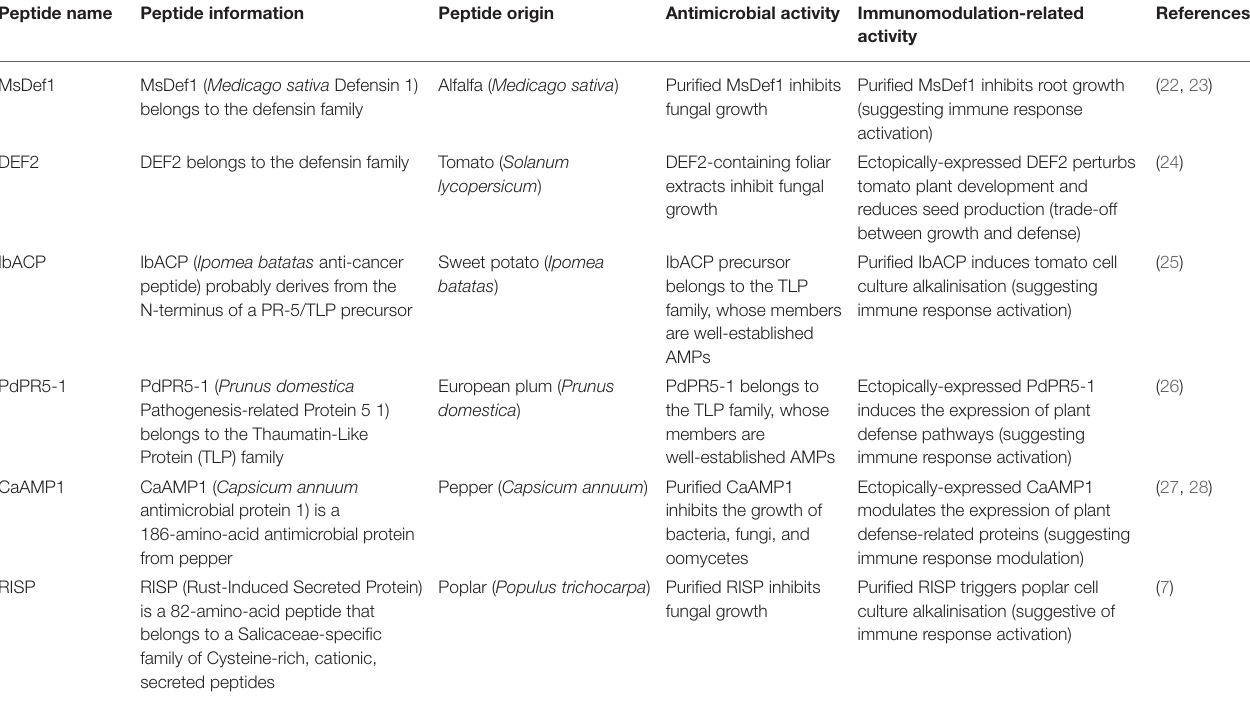
TABLE 1 | Plant HDP